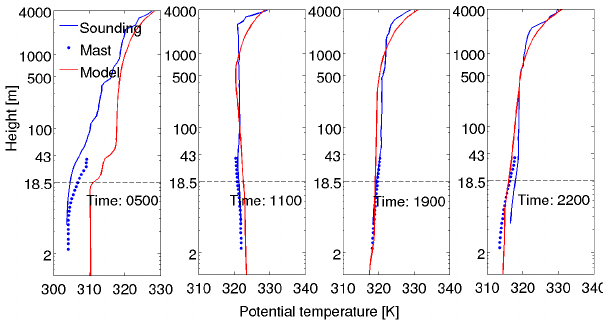
Figure 2. Observed and modeled vertical profiles of potential tem- perature at different time on 22 August 2010 (DOY 234). The y axis (height) is in logarithmic